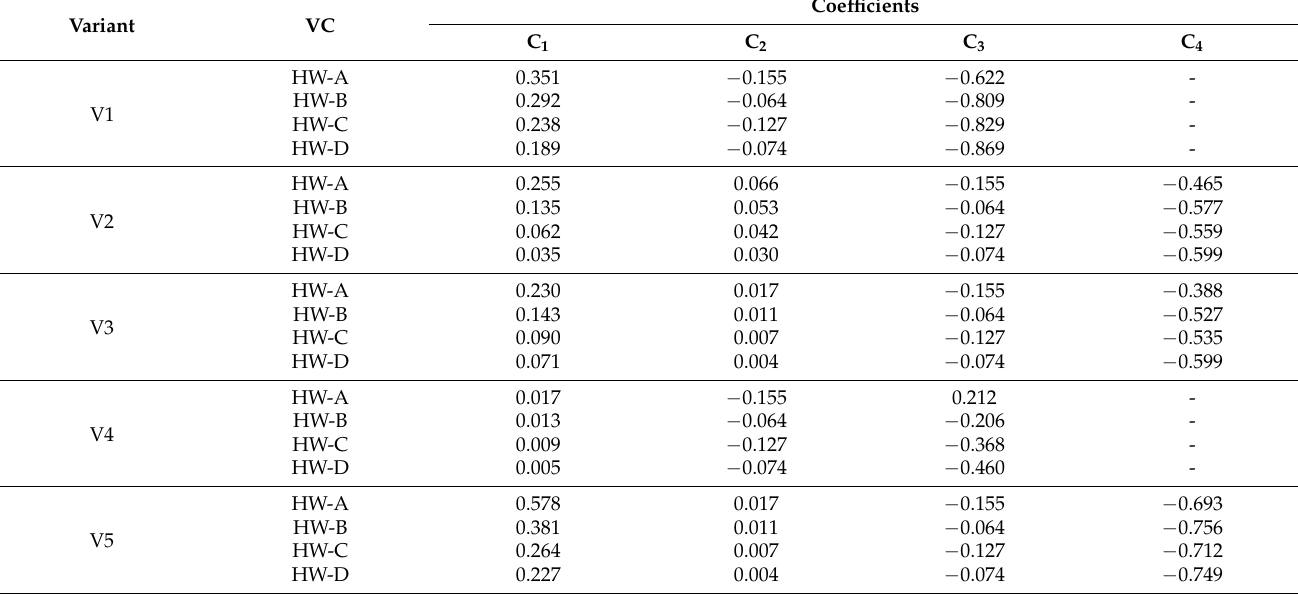
Table 6. Derived coefficients of the vulnerability functions, D m = f(h gl , v fl , n st ).